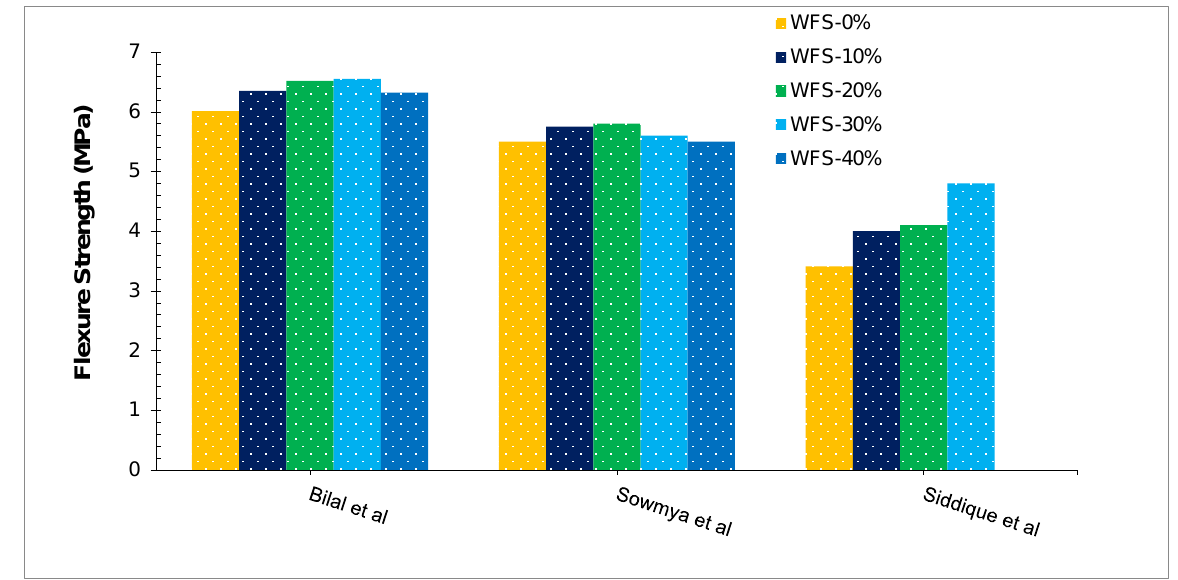
Figure 7. Flexure Strength at 28 days: Bilal et al. [43], Sowmya et al. [50] and Siddique et al. [59]. Table 3. Summary of Fresh and Mechanical performance of concrete with